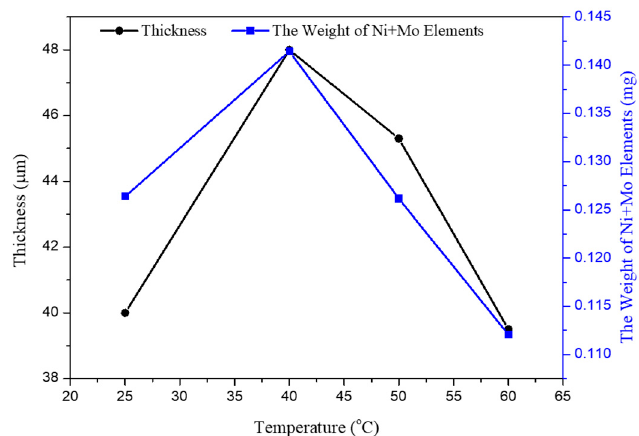
Figure 4. The effect of temperature on the weight of deposited Ni + Mo elements in the coatings and thicknesses of coatings obtained at the conditions mentioned in the caption of Figure 1.